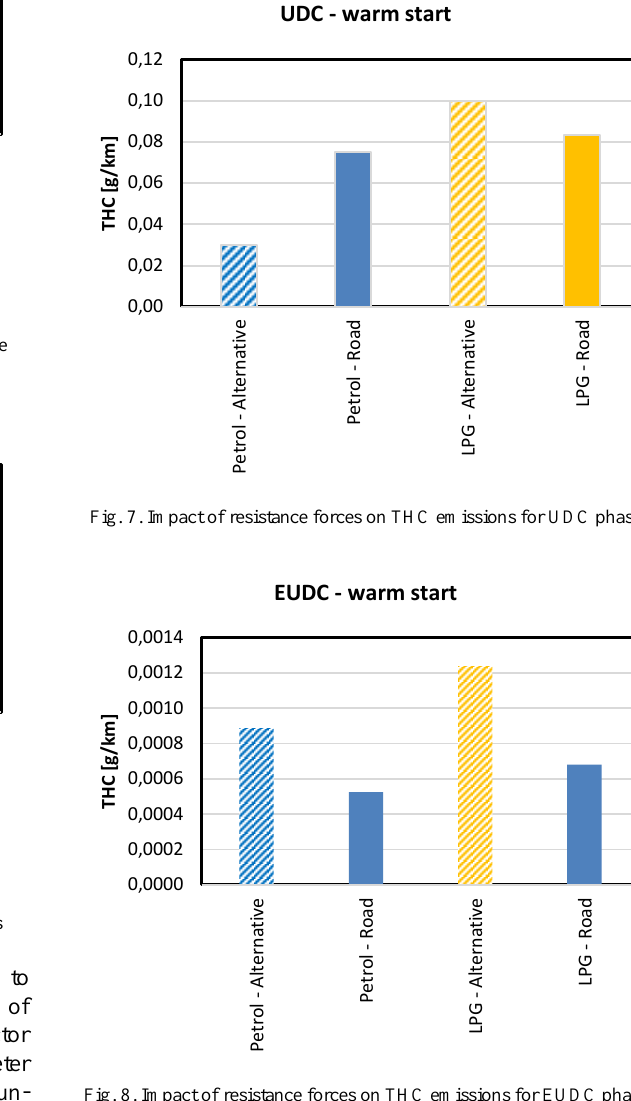
Fig. 8. Impact of resistance forces on THC emissions for EUDC